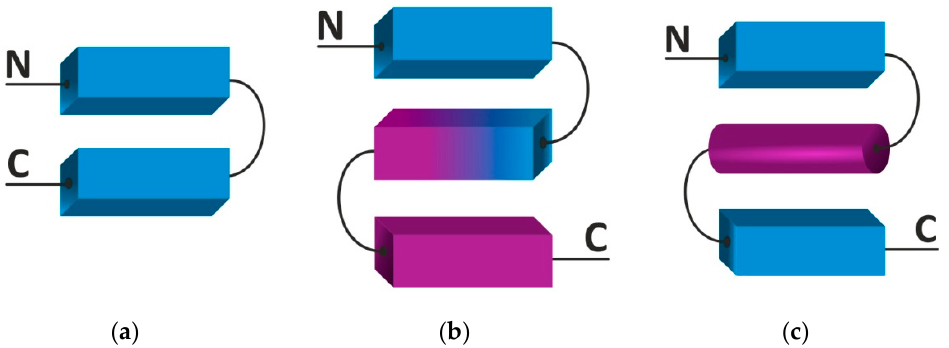
Figure 2. Types of supersecondary structures containing two β -strands, with unique polypeptide chain folding. ( a ) β -hairpin, ( b ) 3 β -corner, ( c ) βαβ motif. Colors indicate elements of the secondary strictures lying in different planes (layers).